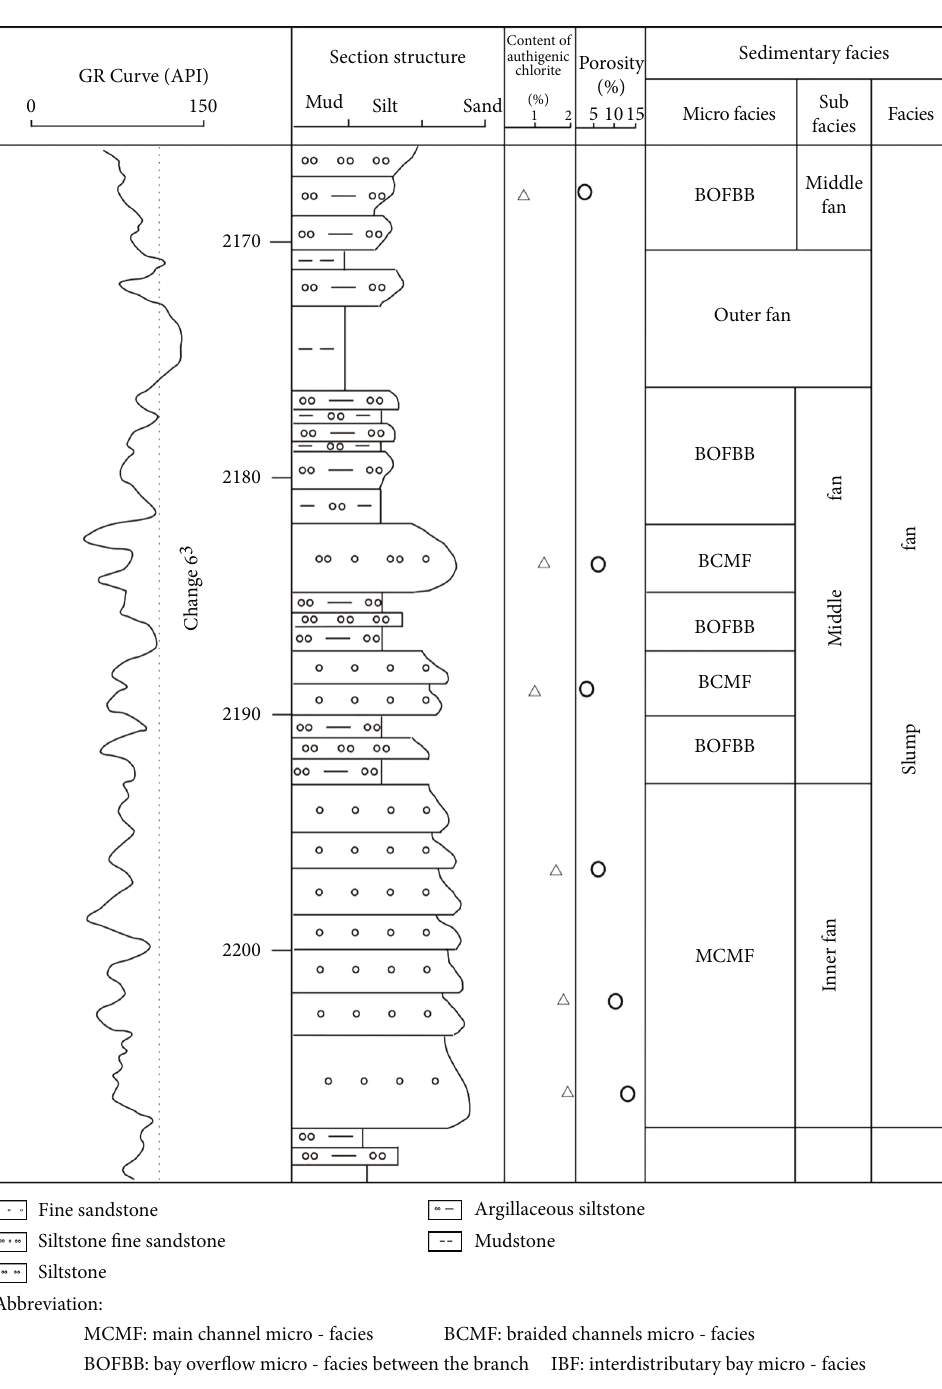
Figure 9: Histogram of Bai115 well in the Chang 6 3